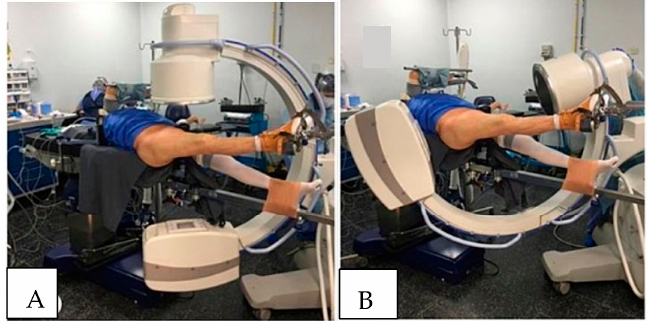
Figure 2. Typical patient positioning in the hemi-lithotomy position for intramedullary nailing and open reduction and internal fixation of proximal femur fractures. ( A ) The well-leg (L) is held flexed at the hip and knee in a generic “well-leg” holder. The operative leg is positioned with the hip and knee extended. ( B ) The C-arm can be positioned to allow an unobstructed image of the hip in both the AP and cross-table lateral images.